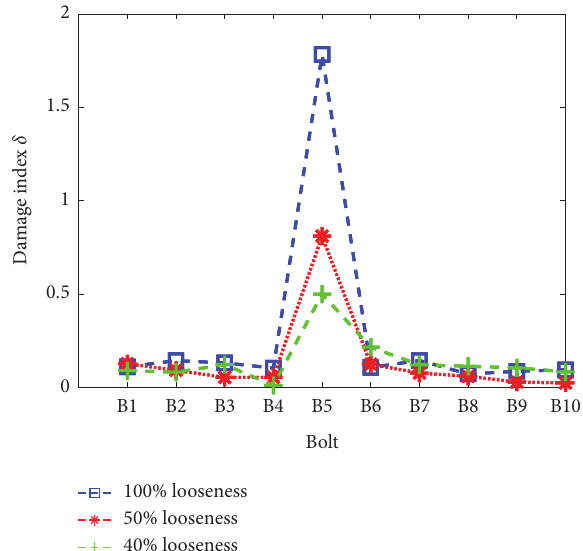
Figure 12: The relationship of damage index for different looseness